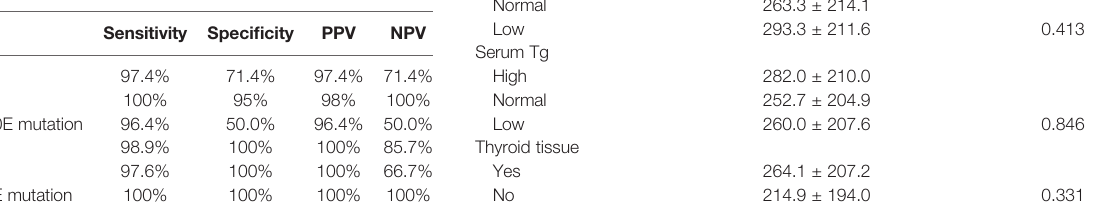
FNAB-C results or BRAF 600E mutation assessments, 27 lymph nodes were found to be metastatic. The sensitivity and speci fi city of FNAB-C combined with BRAF 600E mutation assessment in predicting cervical LNM were 96.4% and 50%, respectively ( Table 4 ). In 56 lymph nodes, both CNB-T and BRAF 600E mutation assessments were performed; in 52 lymph nodes with positive CNB-T results or BRAF 600E mutation assessments, all lymph nodes were found to be metastatic. The sensitivity and speci fi city of CNB-T combined with BRAF 600E mutation assessment in predicting cervical LNM were 100% and 100%, respectively ( Table 4 ).